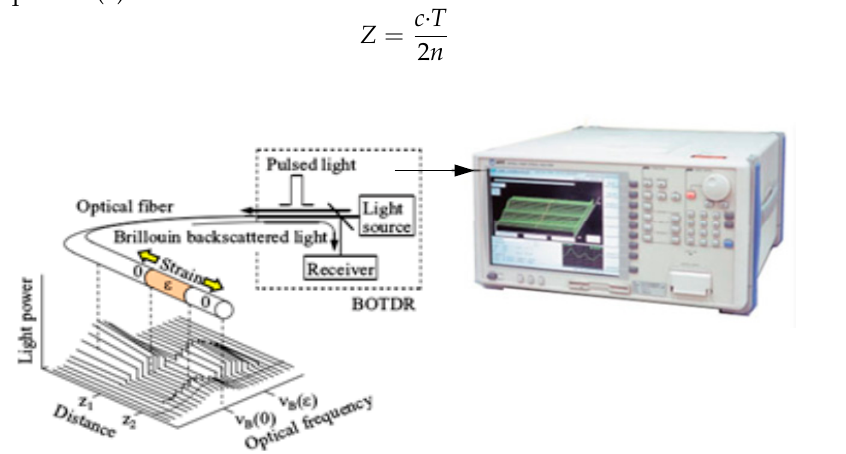
Figure 2. Basic principle of a BOTDR sensor.